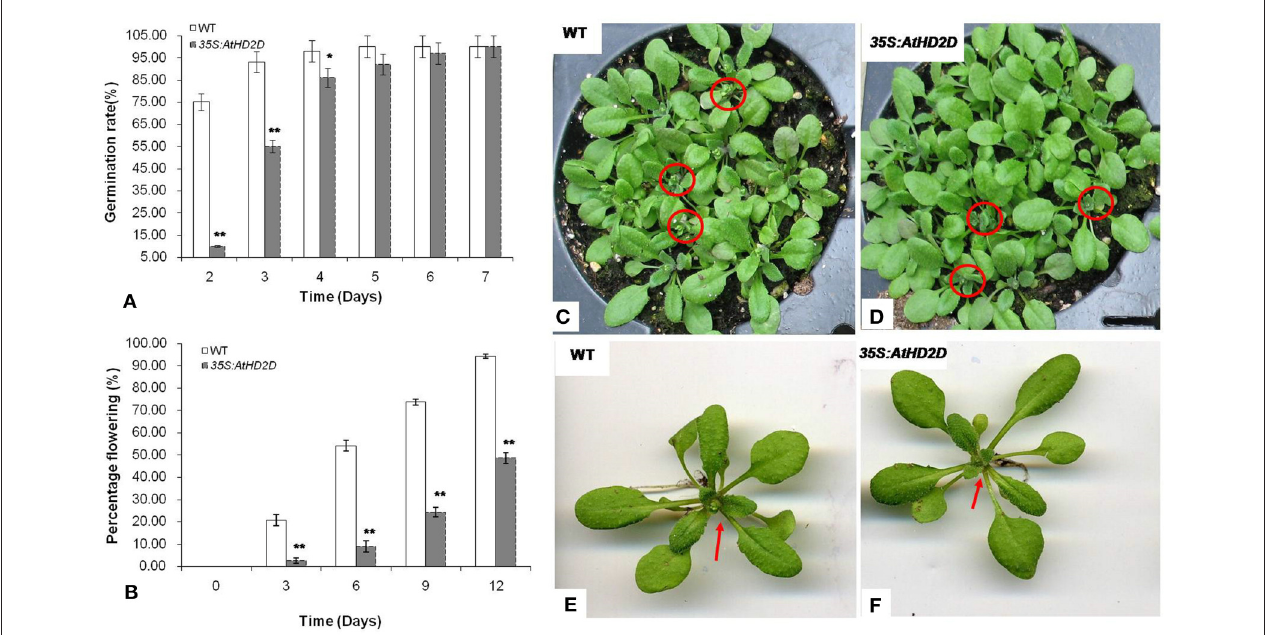
FIGURE 4 | Seed germination and flowering of wild type (WT) and 35S: AtHD2D transgenic plants under regular conditions on MS medium. The data are presented as the mean ± standard deviation of the mean ( SD ) and were tested for significant difference using Student’s t -test ( * p < 0.05 , ** p < 0.01 ). (A) Seed germination rate of WT and 35S:AtHD2D transgenic plants. (B) Plant flowering rate of WT and 35S:AtHD2D transgenic seedlings. (C,E) WT seedlings. (D,F) 35S:AtHD2D transgenic